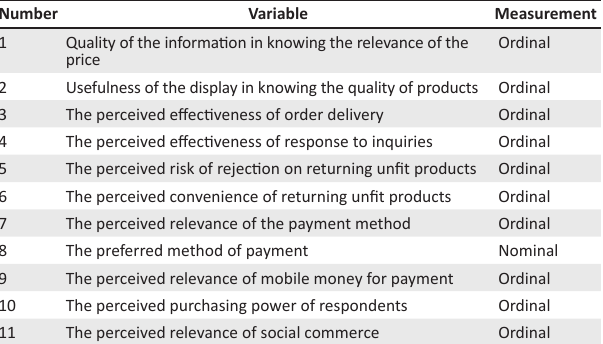
Figure 1 summarises the different relationships proposed by the current study. These relationships are hypothesised as shown below: